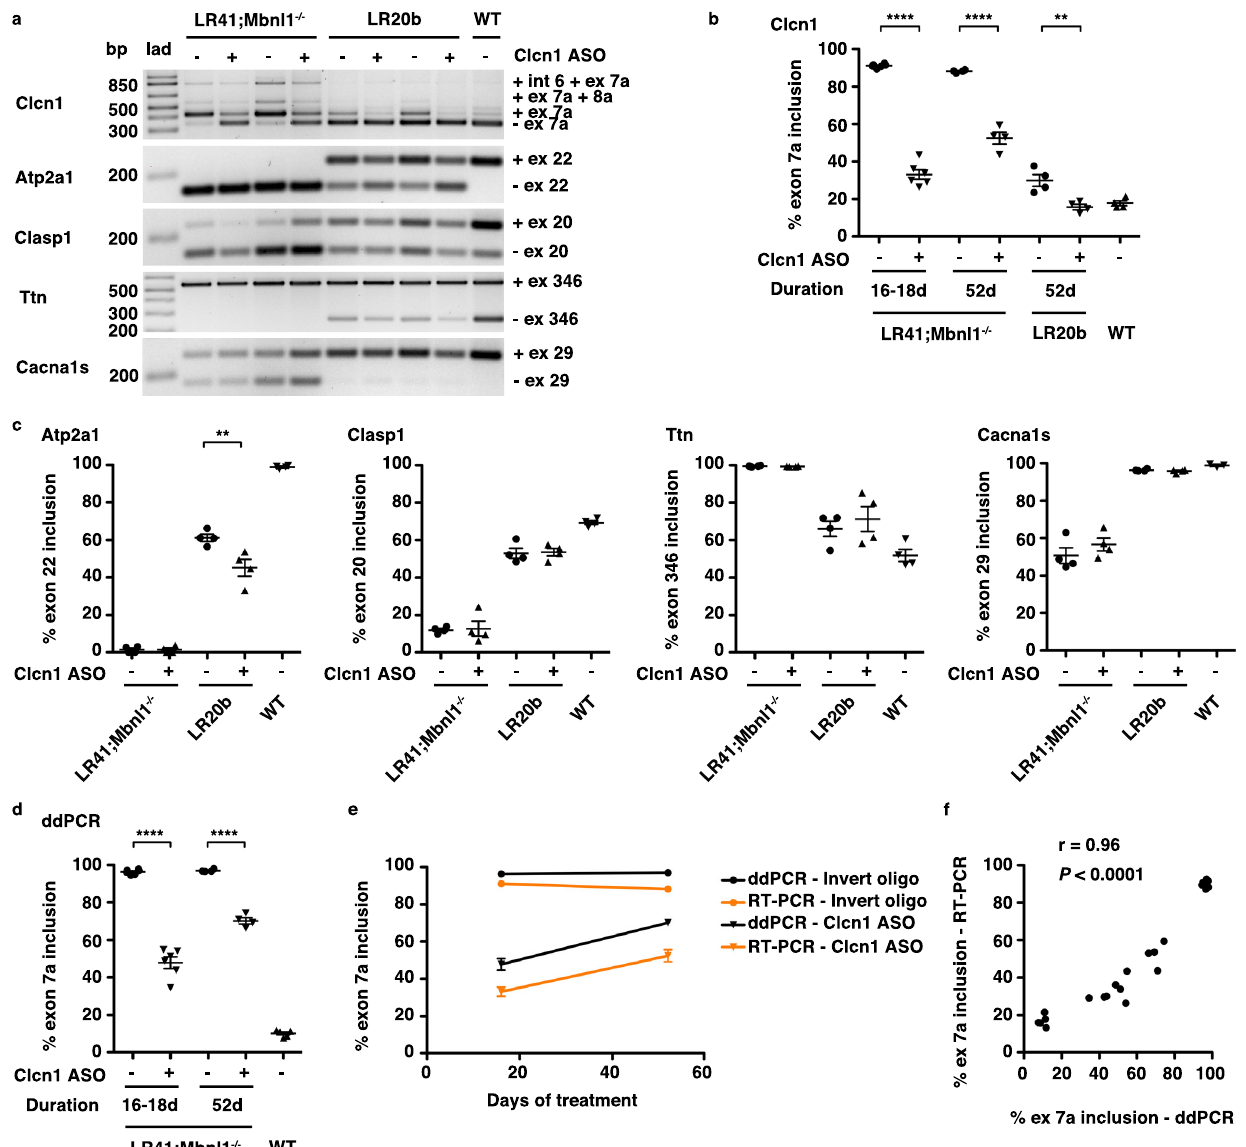
Fig.2|Correctionof Clcn1 alternativesplicinginASO-treatedLR41; Mbnl1 − / − and LR20b mouse muscle. We injected the tibialis anterior (TA) muscle of LR41; Mbnl1 − / − ( N =10) and LR20b ( N =4) with an antisense oligonucleotide (ASO) designed to induce skipping of Clcn1 exon 7a (+). The contralateral TA was injected with a control oligo ( − ) that has an identical but 5 ′– 3 ′ inverted sequence and no target. Untreated wild-type (WT) mice ( N =4 or 5) served as controls. Treatment duration was 16 or 18 days (16 – 18d) or 52 days (52d). a Representative RT-PCR analysis of alternative splicing of Clcn1 exon 7a, Atp2a1 exon 22, Clasp1 exon 20, Ttn exon 346, and Cacna1s exon 29 in muscles treated for 52 days. bp